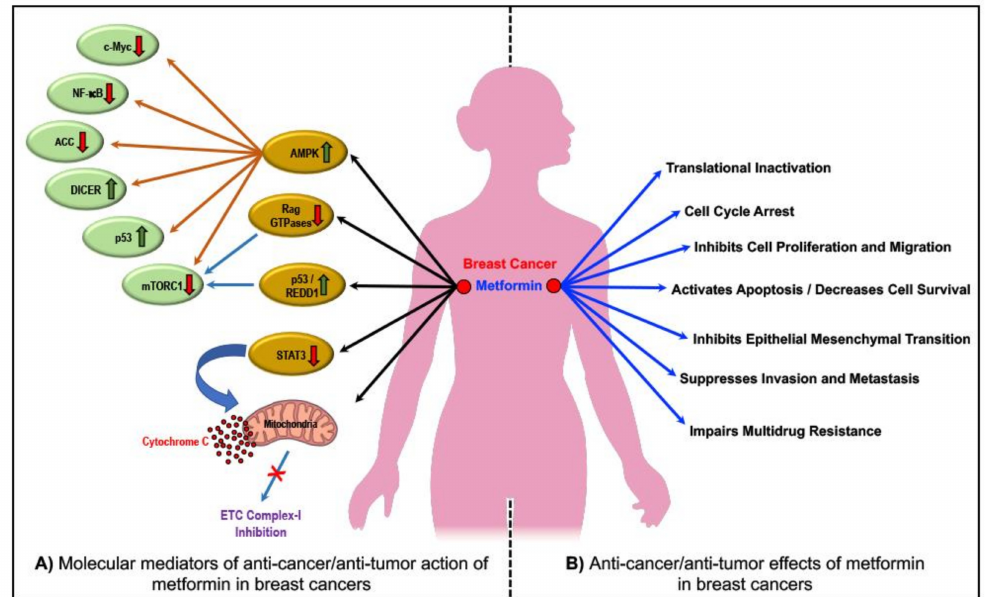
Figure 2. The molecular mediators and ‘direct’ anti-cancer / anti-tumor e ff ects of metformin in breast cancers: ( A ) Metformin treatment-mediated adenosine monophosphate-activated protein kinase (AMPK) activation subsequently involves ‘AMPK-dependent’ inhibition of mTORC1, cellular-Myc (c-Myc), acetyl–CoA carboxylase (ACC), and NF- κ B and pathways and / or activation of p53 pathway and double-stranded RNA specific endoribonuclease (DICER)-dependent pathways. The ‘AMPK-independent’ anti-cancer or anti-tumor e ff ects of metformin reportedly require the activation of regulated DNA damage-1 (REDD1) and / or the inhibition of Rag GTPases and signal transducer and activator of transcription 3 (STAT3)-dependent mechanisms. ( B )